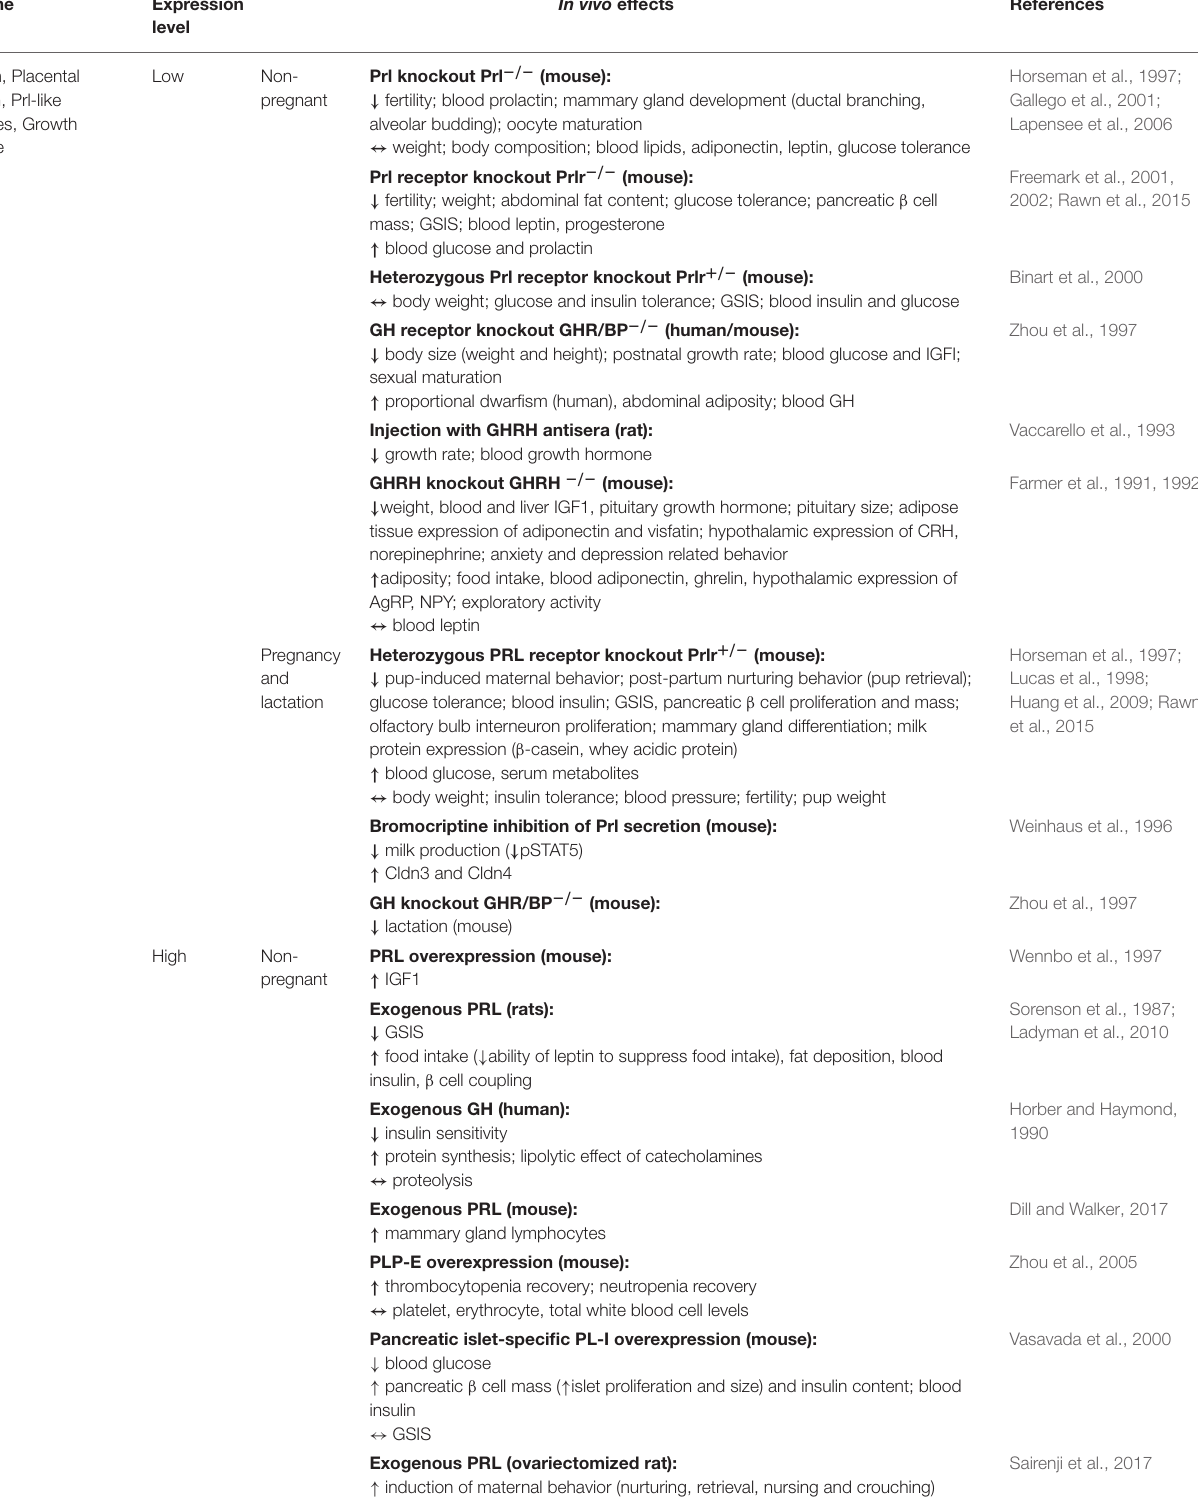
TABLE 1 | Effects of the prolactin-growth hormone family in vivo